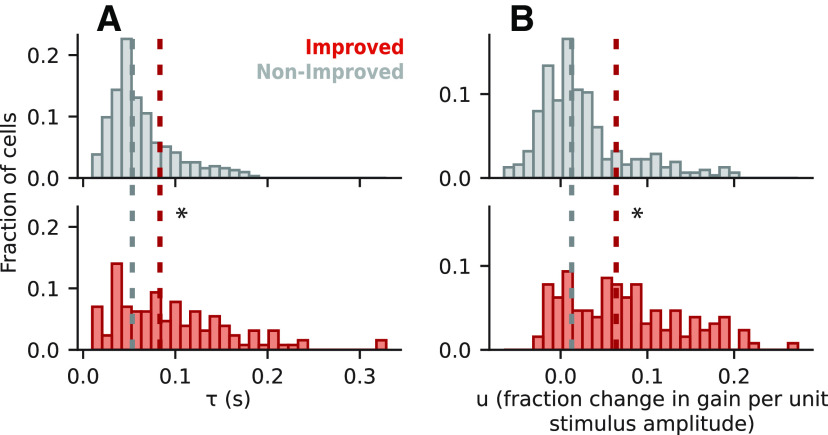
Parameter fit values for the STP model. A, Distribution of τ, representing the time constant for the recovery of synaptic vesicles, Top panel shows data for non-improved neurons (gray) and bottom panel for improved neurons (red). Median values for non-improved (0.0533 s) and improved (0.0833 s) neurons were significantly different (p = 3.53 × 10−6, two-sided Mann–Whitney U test, * p < 0.05), indicating a longer time constant for the improved cells. B, Distribution of u values, representing release probability (i.e., the fraction change in gain per unit of stimulus amplitude). Medians for non-improved (0.0128) and improved (0.0641) neurons were significantly different (p = 2.92 × 10−13), showing higher release probability for neurons with improved performance over the LN model.